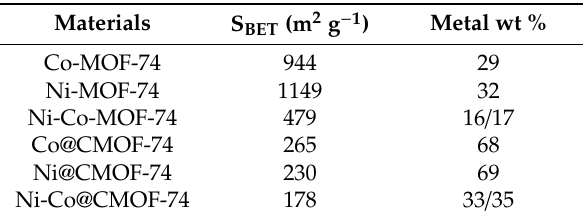
Table 1. BET and inductively coupled plasma (ICP)-MS results of the metal-organic frameworks (MOFs) mediated